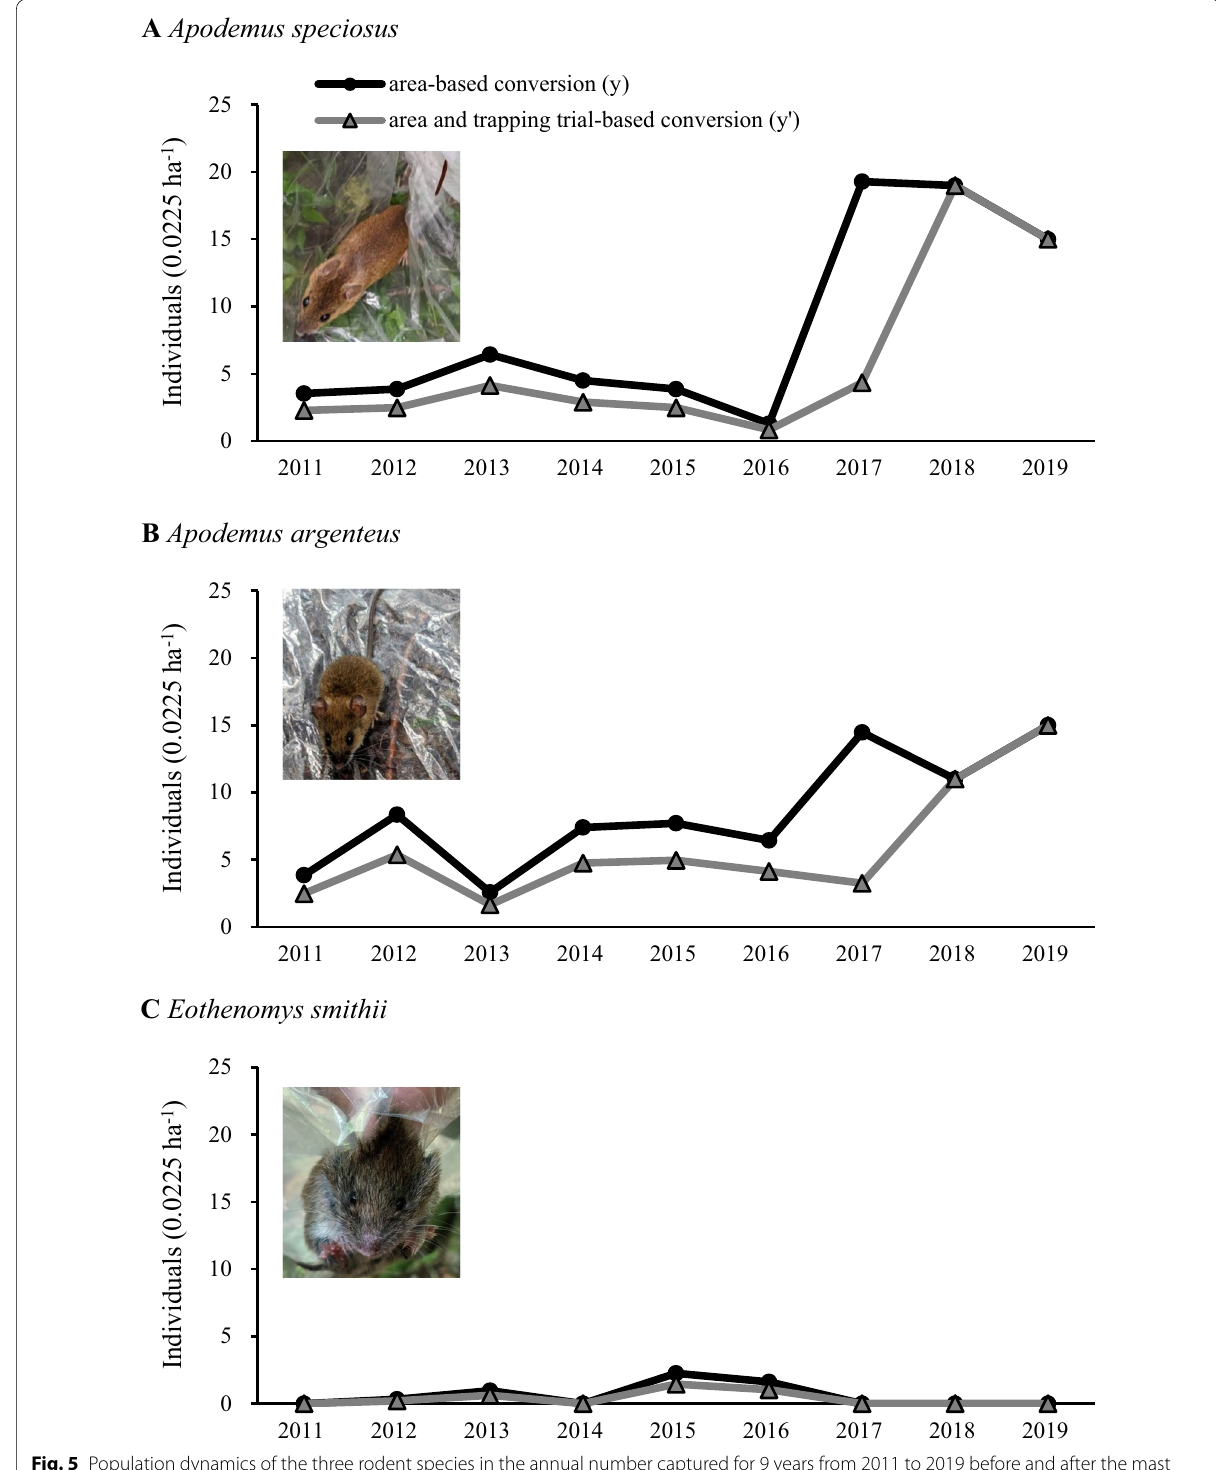
Fig. 5 Population dynamics of the three rodent species in the annual number captured for 9 years from 2011 to 2019 before and after the mast seeding. A Apodemus speciosus , B Apodemus argenteus , and C Eothenomys smithii . Black ( y ) and gray ( y’ ) lines represent values per the unit area (0.0225 ha) and the unit area (0.0225 ha), inclusive of trapping trial (72 trap nights),